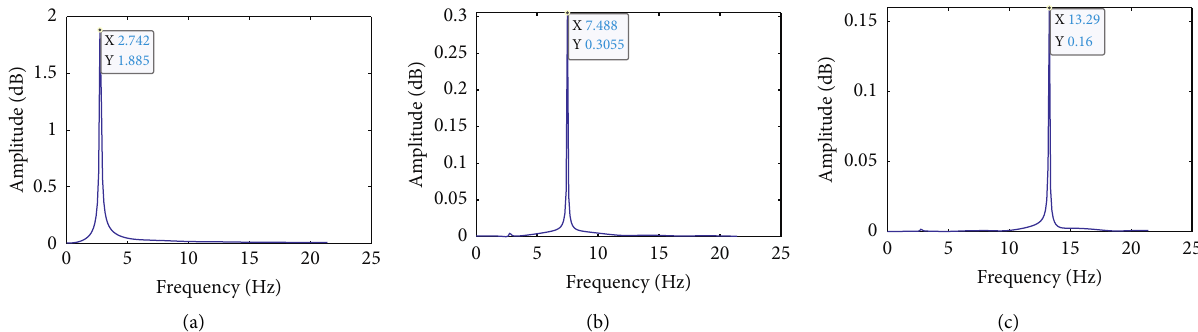
Figure 5: Spectrum of flexible generalized coordinates: (a) spectrum of q